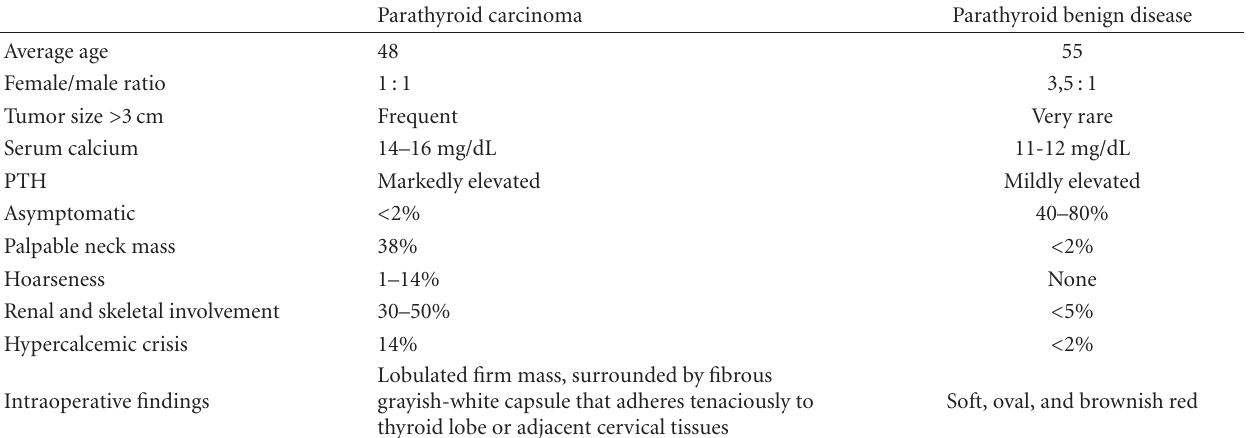
Table 3: Typical features of PHPT secondary to parathyroid carcinoma versus parathyroid benign